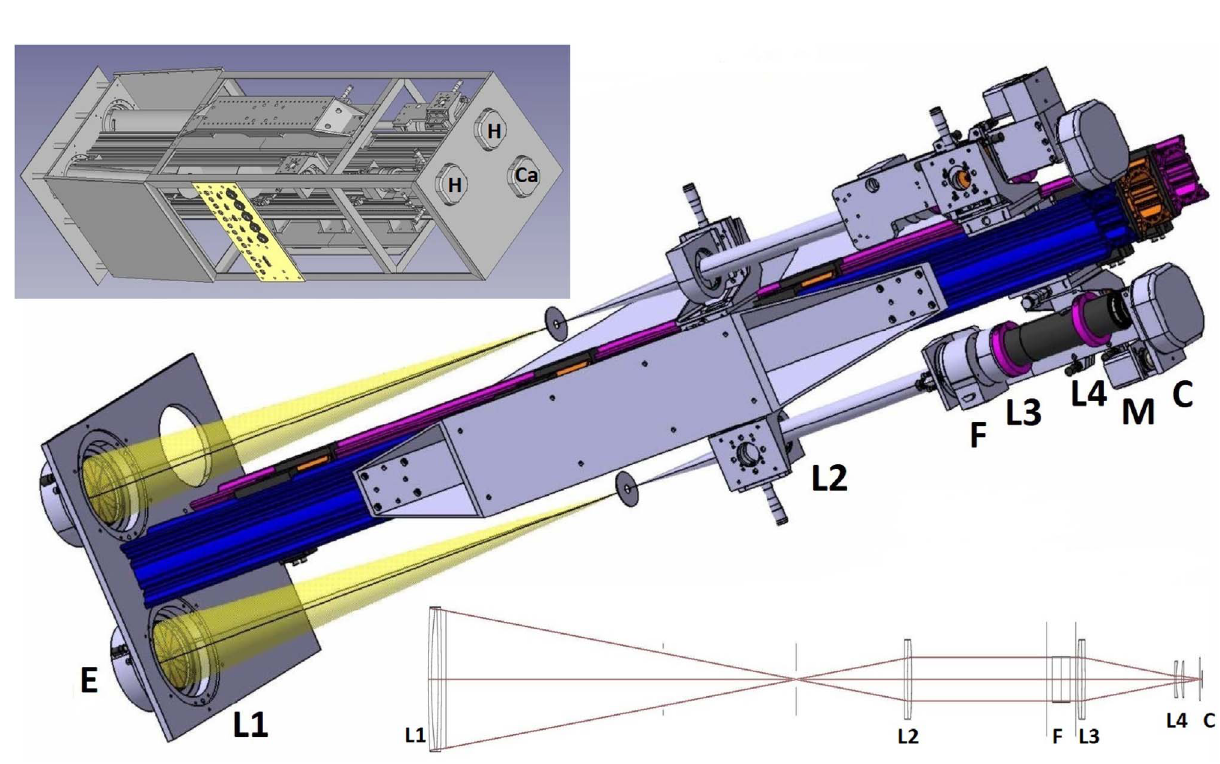
Fig. 1. Top: the MeteoSpace overall structure (0.5 (cid:3) 0.5 (cid:3) 1.7 m) enclosing three instruments; H = H a ; Ca = CaII K. Middle: details of the two H a telescopes; E = energy rejection fi lter (Baader); L1 = entrance objective (Takahashi TSA102); L2/L3 = afocal magnifying system; F = DayStar Quantum PE Fabry Pérot fi lter; L4 = fi eld corrector/focuser; M = focuser motor; C = cooled CCD camera (QSI 660i). Bottom: optical design of the H a